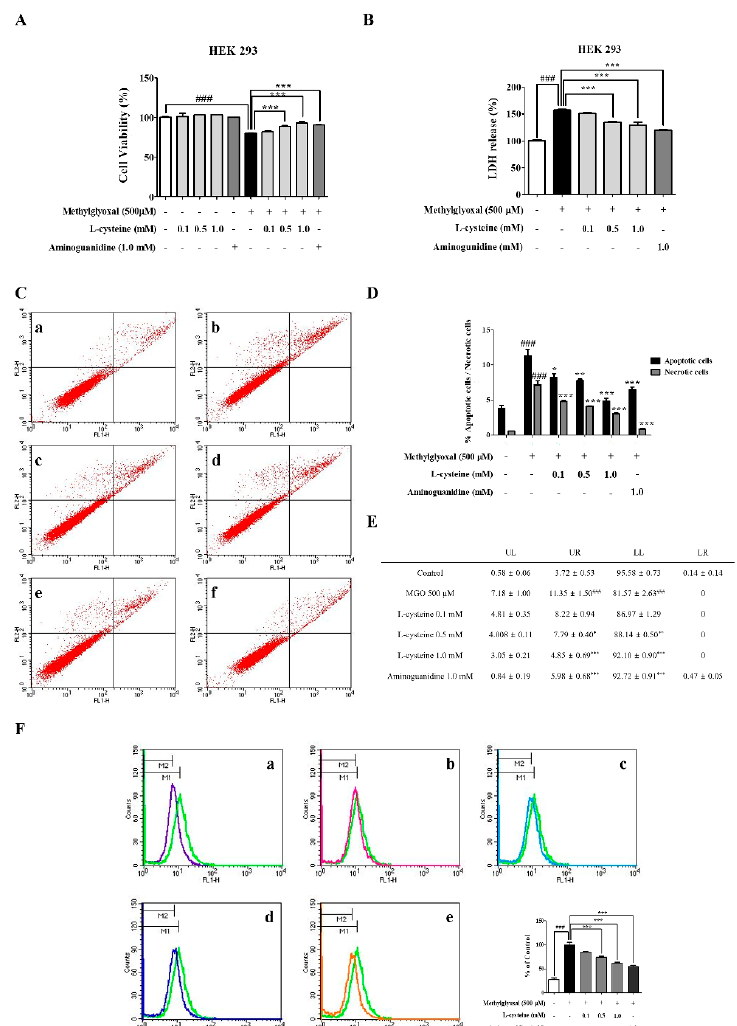
Figure 6. E ff ects of l -cysteine on MGO-induced cell toxicity and ROS generation in HEK 293 cells. ( A ) Cell viability of HEK 293 cells with MGO (500 µ M) and various concentrations of l -cysteine (0.1, 0.5, and 1.0 mM) and analyzed using the MTT assay. ( B ) MGO-induced LDH production was evaluated by LDH assay in HEK 293 cells. ( C ) Representative cytograms of Annexin V-FITC and PI staining of MGO-induced HEK 293 cells. Cells were pre-treated with several concentrations l -cysteine for 1 h, then incubated with MGO (500 µ M) for 24 h. After 24 h, the concentrations of viable (Annexin V-FITC and PI negative cells), early-stage apoptotic (Annexin V-FITC positive, PI negative cells), late-stage apoptotic (Annexin V-FITC positive, PI-positive cells), and necrotic (PI-positive cells) cells were analyzed by flow cytometry. ( a ) control; ( b ) 500 µ M MGO; ( c ) MGO + l -cysteine (0.1 mM); ( d ) MGO + l -cysteine (0.5 mM); ( e ) MGO + l -cysteine (1.0 mM); ( f ) MGO + AG (1.0 mM) as a positive control. ( D , E ) Percentage of control, early-stage apoptotic, late-stage apoptotic, and necrotic cells as analyzed by flow cytometry. ( F ) MES13